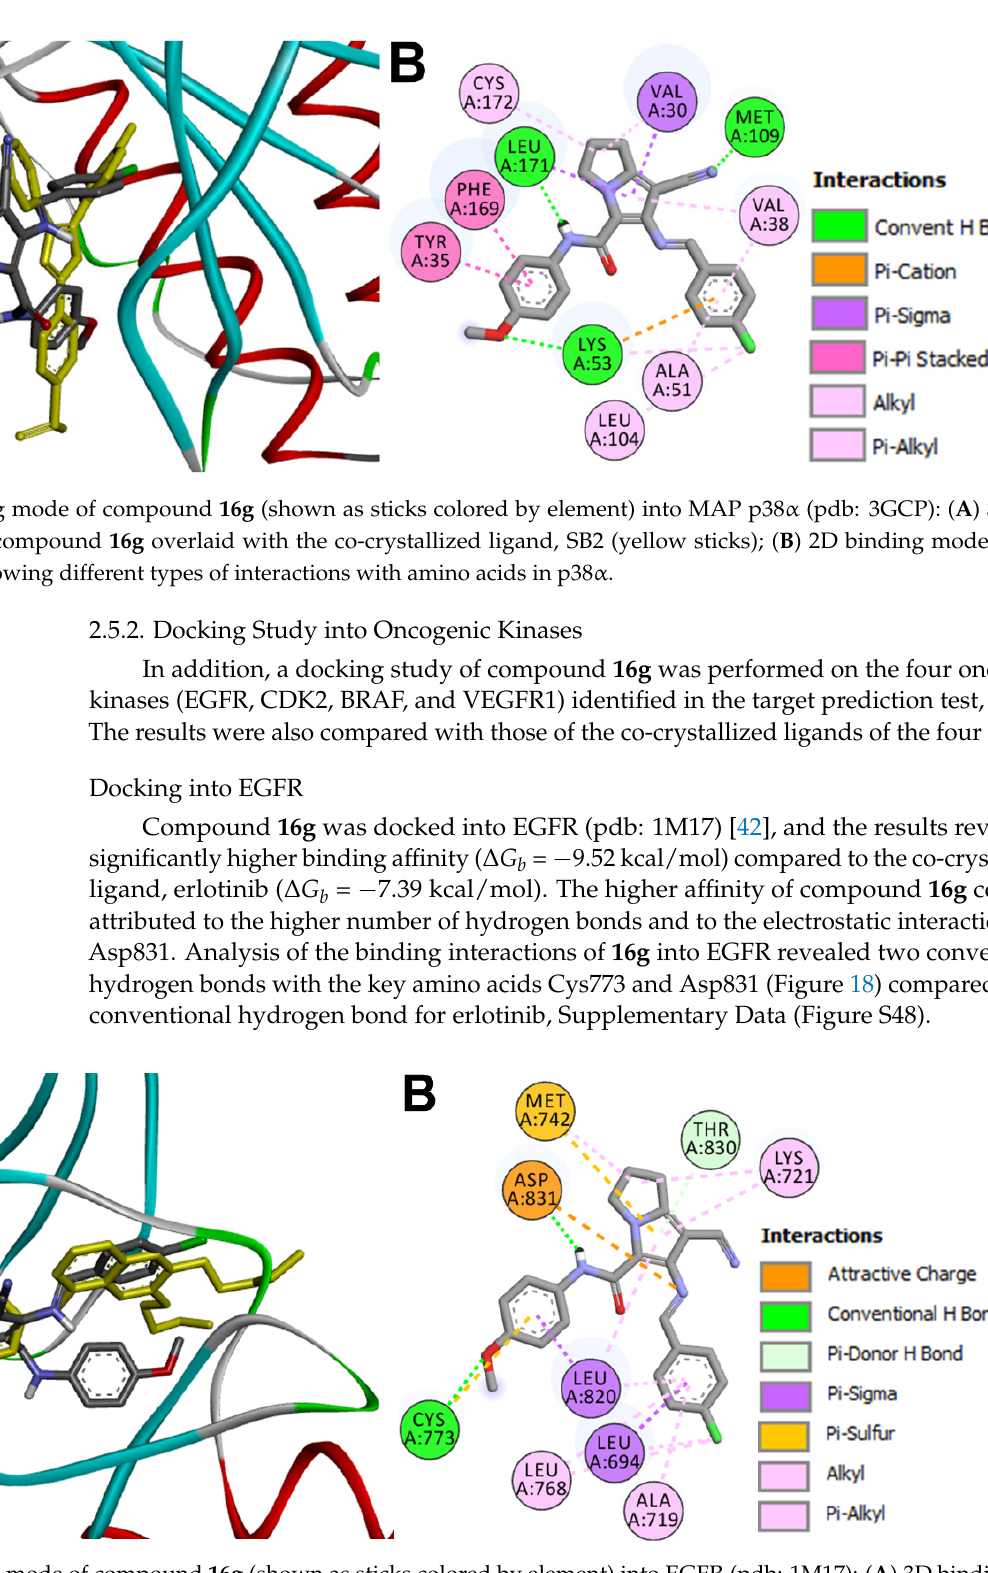
Figure 18. Binding mode of compound 16g (shown as sticks colored by element) into EGFR (pdb: 1M17): ( A ) 3D binding mode of compound 16g overlaid with the co-crystallized ligand, erlotinib (yellow sticks); ( B ) 2D binding mode of compound 16g showing different types of interactions with amino acids in EGFR.